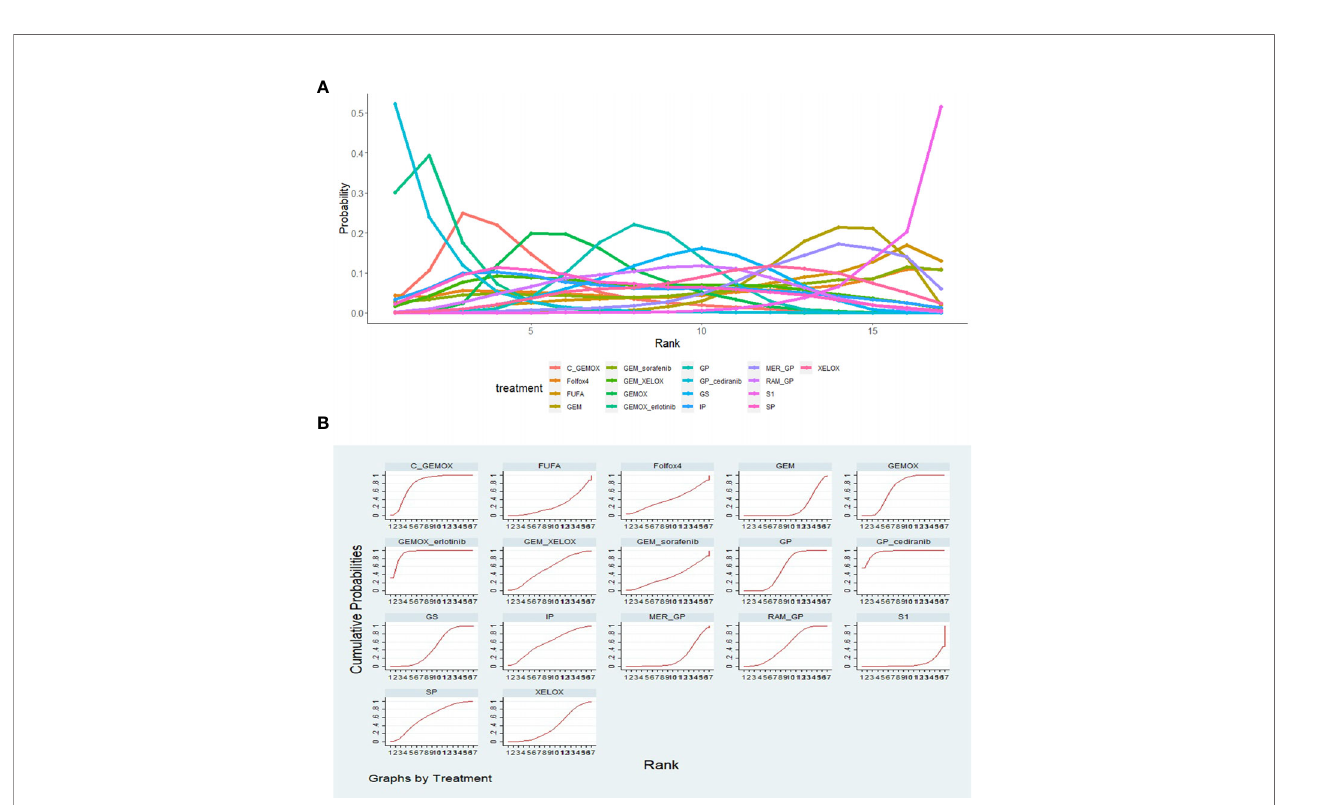
FIGURE 5 | (A) Network evidence diagram of objective remission rate (ORR) of each protocol; (B) Bayesian network meta-analysis (NMA) results of ORR of each protocol.